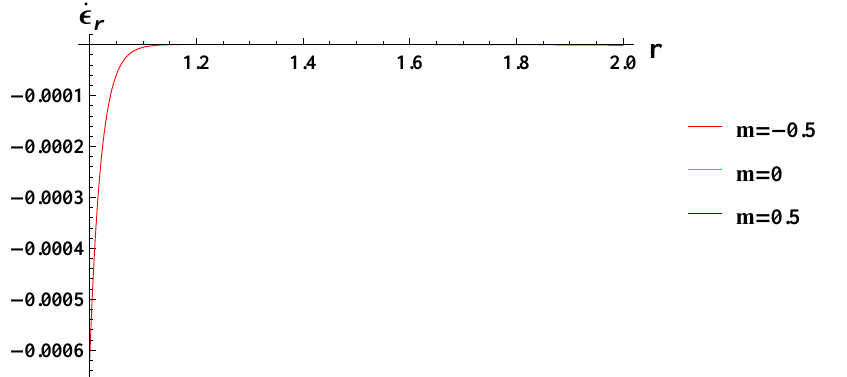
Figure 17. Tangential stress (in MPa) along the radius r (in cm) of the cylinder, under the effect of rotation ( ω 2 = 50 rad/s), external pressure p o = 50 MPa and linear volume reinforcement.